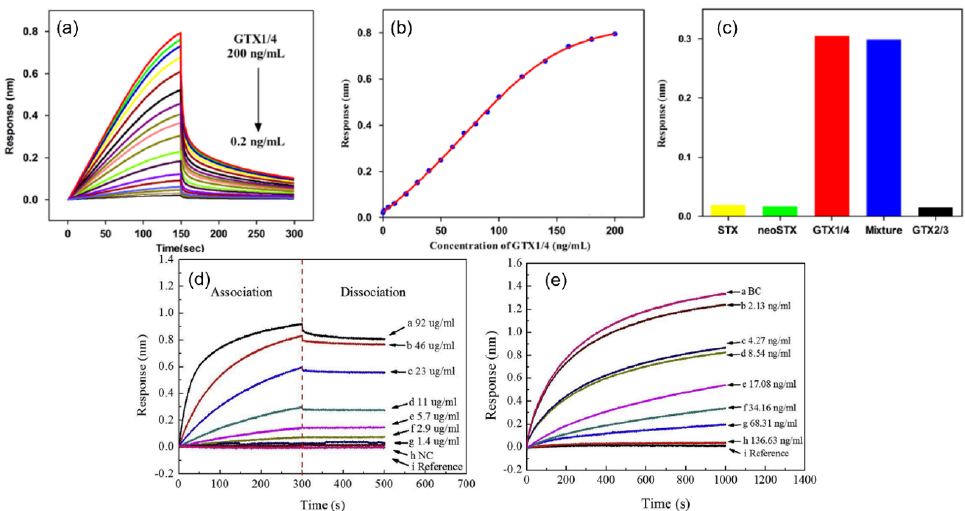
Figure 14. ( a ) Real-time detection after introduction of GTX1/4 at concentrations in between 0.2 and 200 ng/mL. ( b ) Response versus concentrations. ( c ) Evaluation on specificity of the sensor using other toxins. Reproduced from ref. [92] with permission from Elsevier. ( d ) Binding of RepA protein to the dsDNA OP1. ( e ) Measurement results of testosterone. Reproduced from ref. [93] with permission from Elsevier.